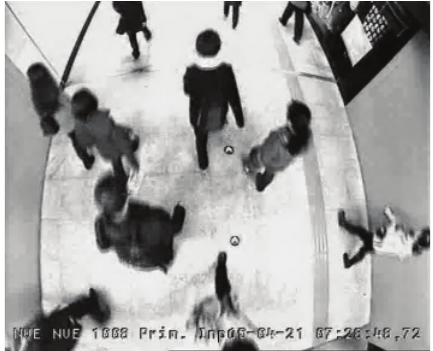
Figure 4: Pedestrian Detection Software.